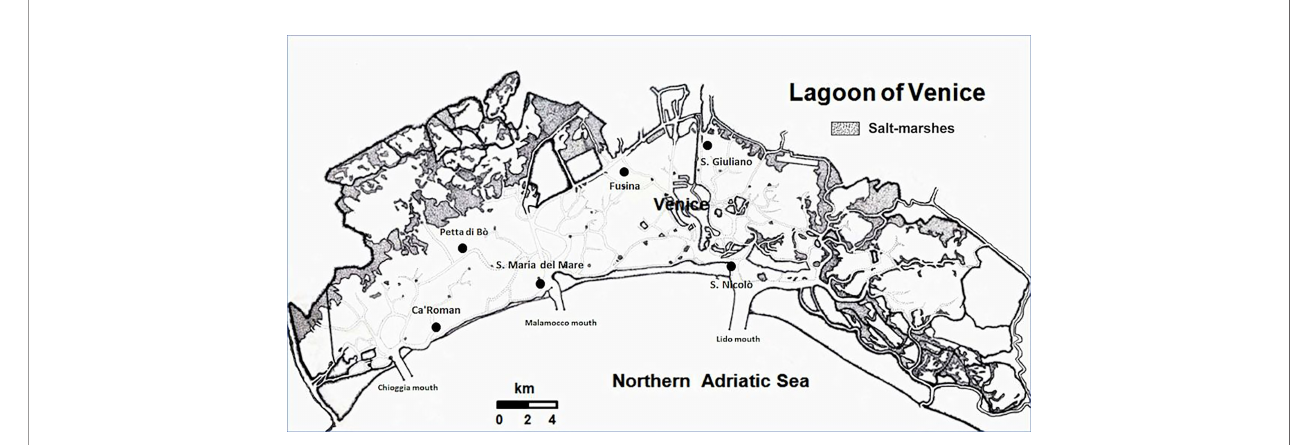
FIGURE 1 | Map of the Venice Lagoon and the 6 stations